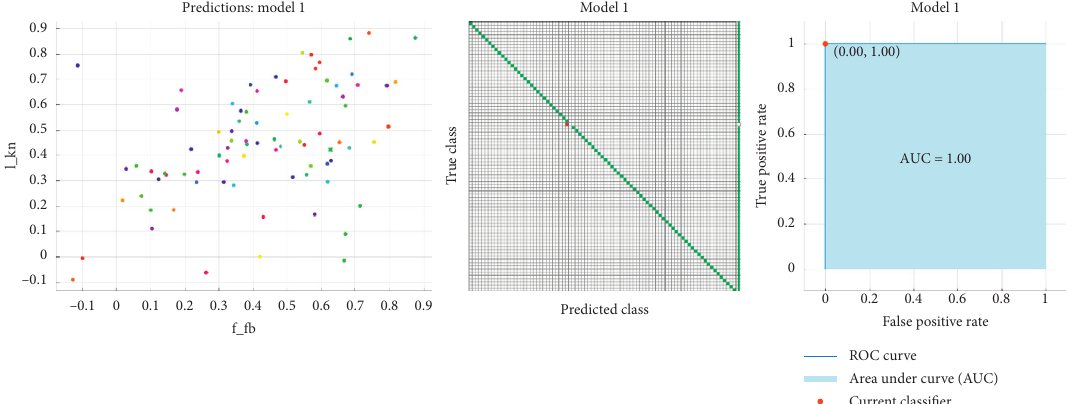
Figure 16: Gait recognition with Cross-Correlation Score, confusion matrix, and ROC curve of